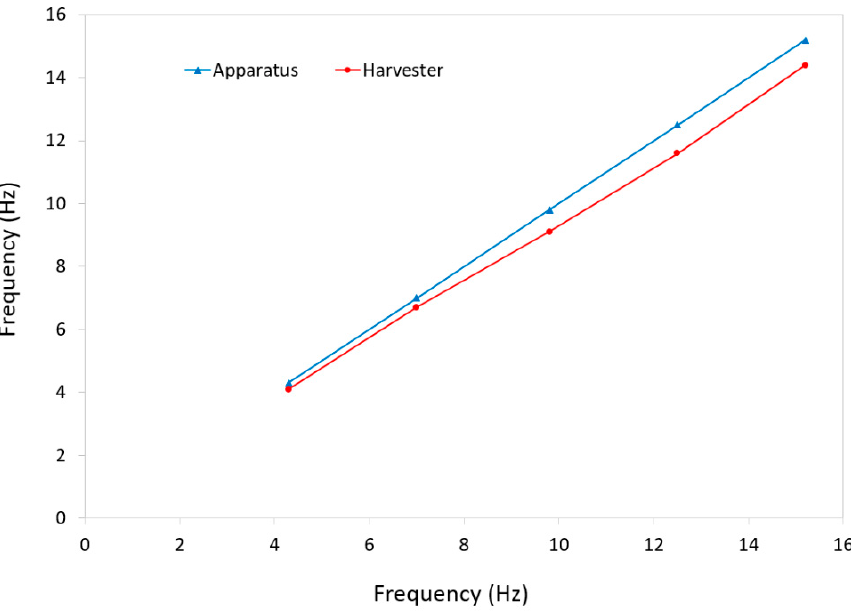
Figure 9. A comparison between the frequency of the testing apparatus and that of the energy har- vester.